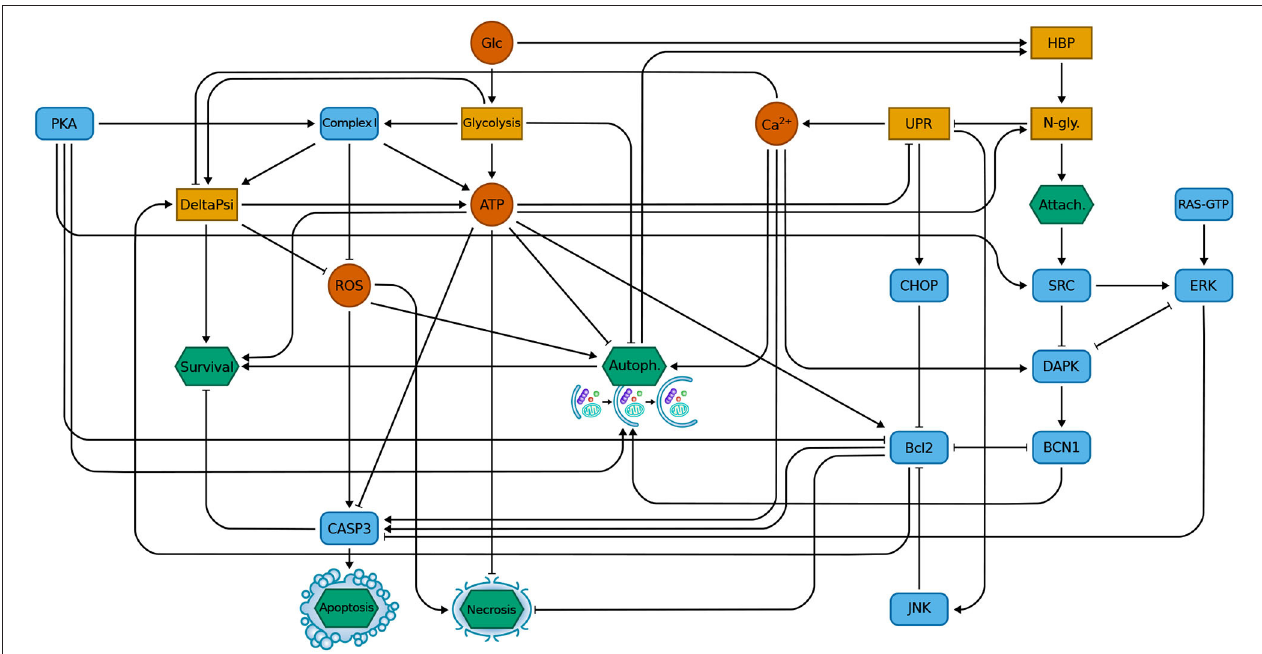
FIGURE 1 | The interaction map of the programmed cell death model, showing the mutual regulation of the components. In the figure, single molecules are represented by red circles; blue rounded rectangles represent proteins; orange rectangles denote processes; green hexagons represent the outputs of the model. Positive and negative regulations are denoted as arrows and blunt-ended arrows, respectively. Figure adapted from Nobile et al.